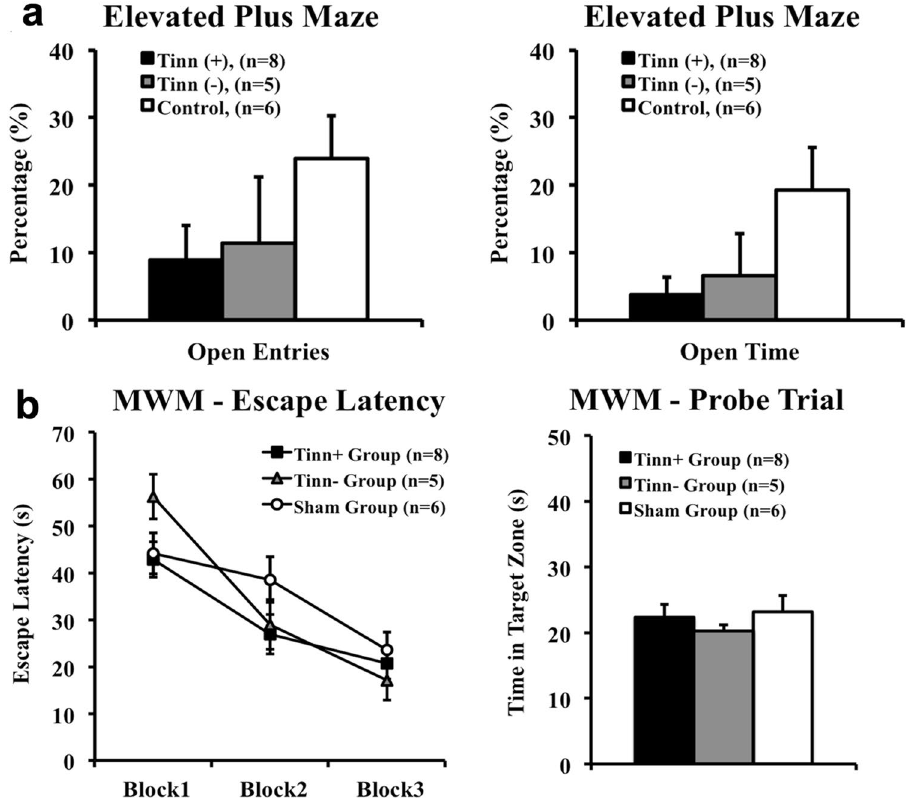
Figure 2. Blast-exposed rats as a whole exhibited significant anxiety, but no significant deficits in spatial learning or memory. ( a ) On the elevated plus maze (EPM), the only significant between-group difference was how blasted rats as a whole (tinnitus( + ) and tinnitus( − ) rats) committed significantly less open-arm time compared to control (ctrl) rats. Rats were tested five weeks following blast and were compared based on the percent of open-arm entries and time, relative to total entries and time. ( b ) No significant between-group differences were observed during escape latency trials or the probe trial of the Morris water maze (MWM). Rats were tested five weeks following blast. Each block consisted of 4 escape latency trials, where latency to locate the hidden platform was measured. Time spent in the former hidden platform quadrant, or target zone, was measured in the probe trial. For all graphs, error bars represent standard error of the mean. * Indicates significance (p < 0.05) between blasted rats as a whole (tinnitus( + ) and tinnitus( − ) rats) vs. control